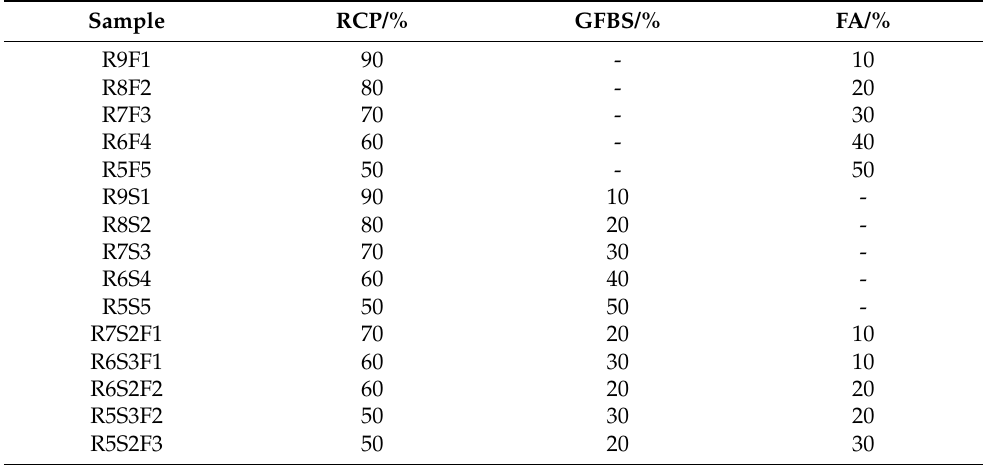
Table 2. Mix proportions of composite cement pastes.